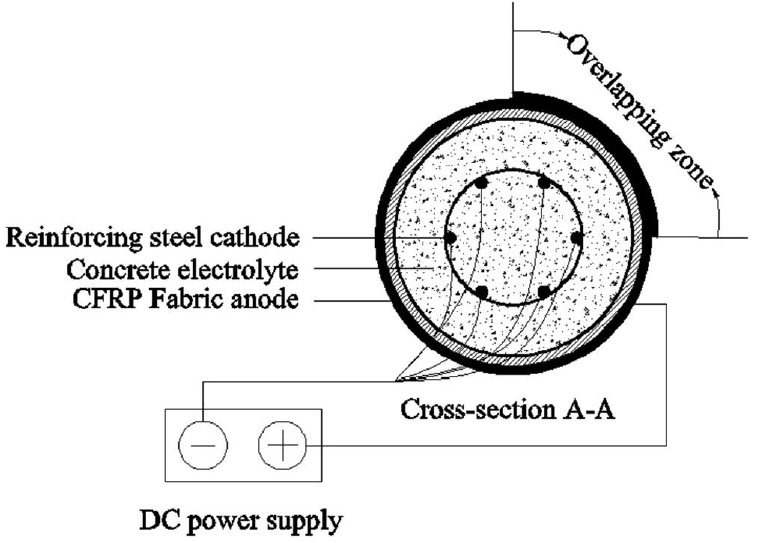
Figure 21. Schematic of ICCP for corroded RC members. Reproduced with permission from [141], Elsevier, 2018.